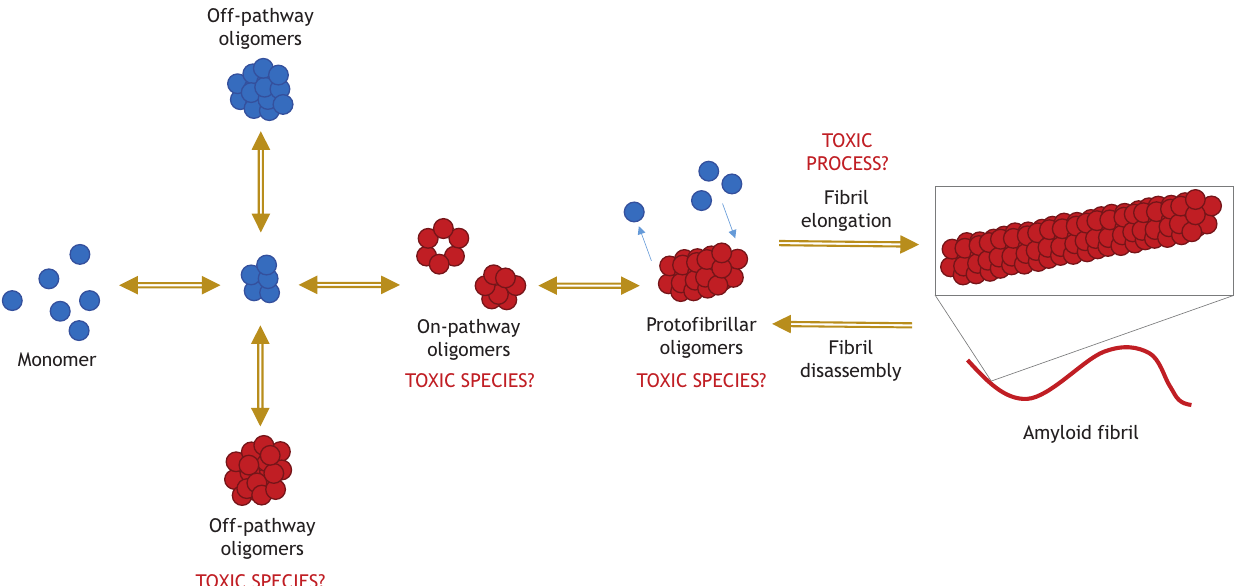
Figure 3. Toxic (cid:2)-synuclein oligomers in relation to the pathway of amyloid fibril formation. Toxic oligomers have been reported by different studies as being “on-pathway” or “off-pathway” to amyloid fibril formation. Covalent bonding by oxidative modifications may be involved in stabilizing toxic “off-pathway” oligomers. Non-toxic oligomers that are “off-pathway” are stabilized by pharmacological inhibitors of fibril formation, such as baicalein. Toxicity of oligomers is likely to be related to their high levels of (cid:3)-sheet secondary structure. Additionally, it has been hypothesized that protofibril/fibril elongation may be toxic. Blue circles- Little or no (cid:3)-structure; Red circles- High